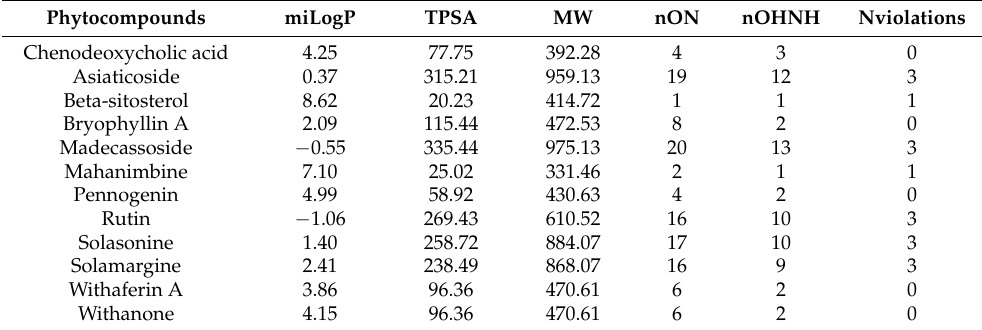
Table 3. Drug likeness prediction of 11 active phytocompounds of 8 medicinal plants.